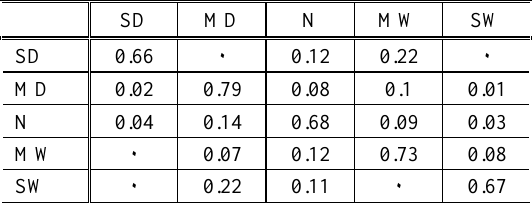
Table I: Probability model for drought based on SPI index